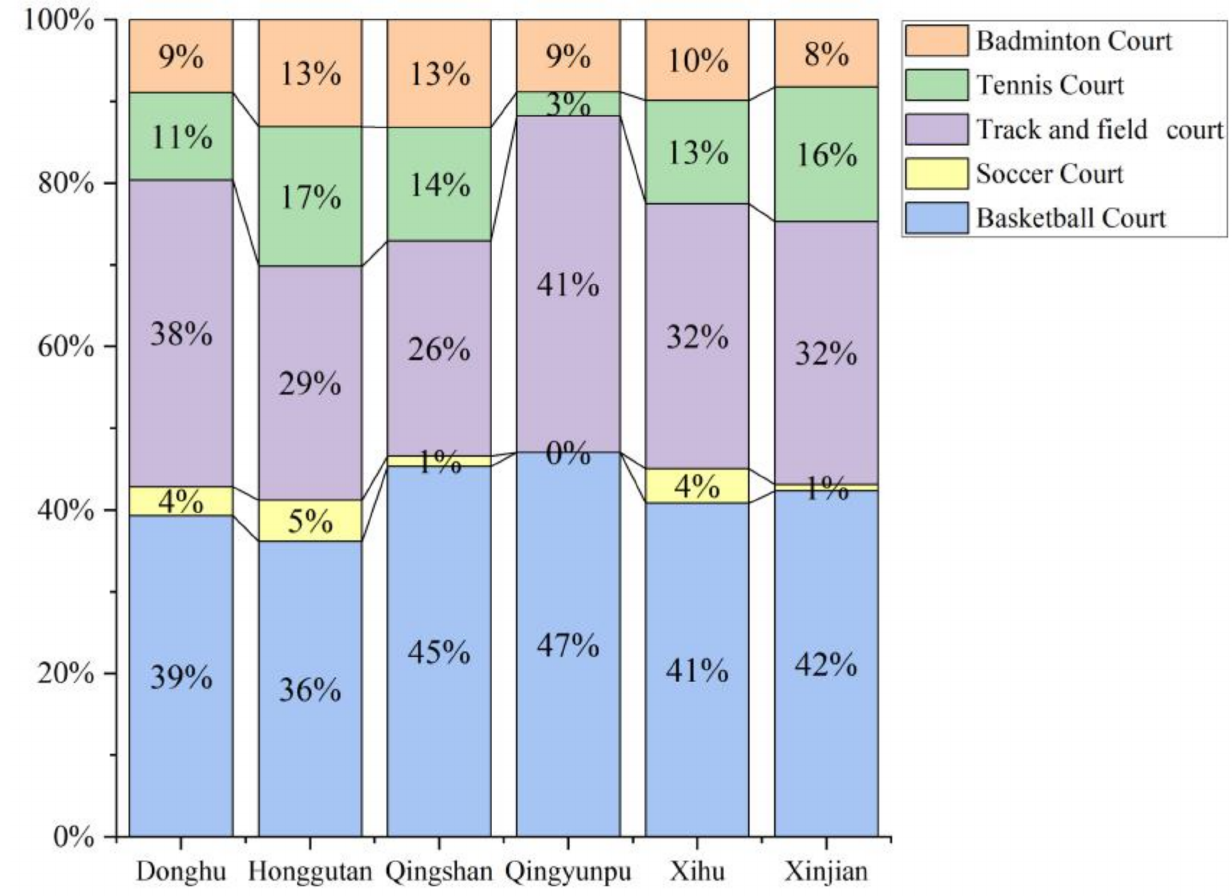
Figure 7. The relative structural proportion of outdoor sports venues in each